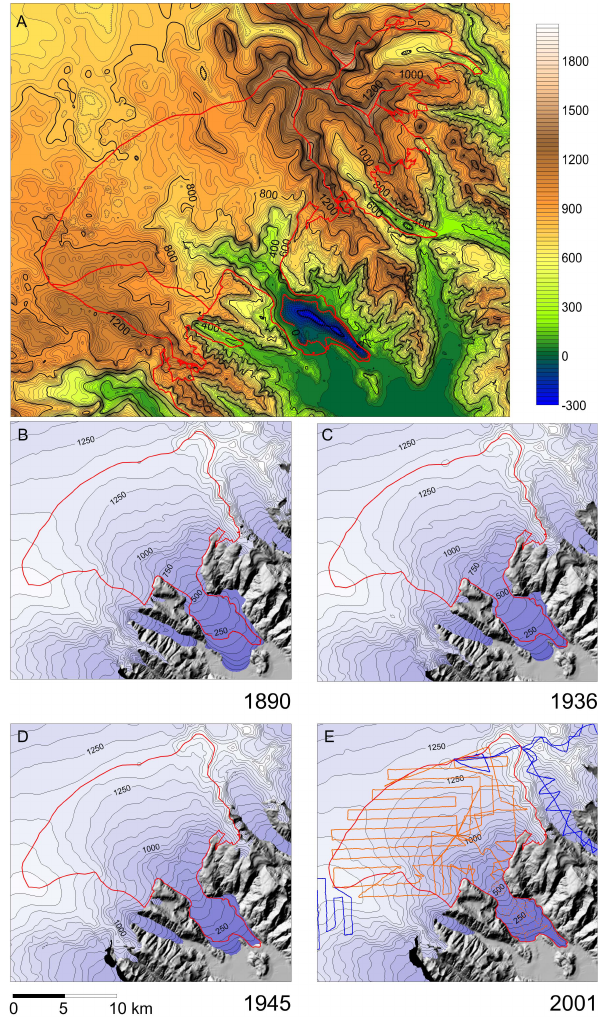
Fig. 2. (A) Measured bedrock topography of Hoffellsjökull (2001). Blue colours indicate elevation below sea level. (B–E) Surface to- pography at different times, showing retreat and thinning during the 20th century. The radio-echo sounding (RES) line network and sites of RES point survey is shown in (E) . The red line is the 2001 ice divide for Hoffellsjökull (212km 2 ).